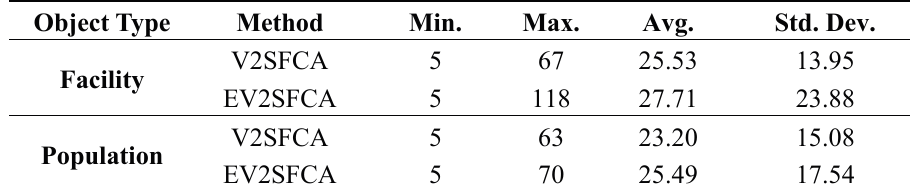
Table 1. Statistics of facility and population catchment sizes determined by V2SFCA and EV2SFCA